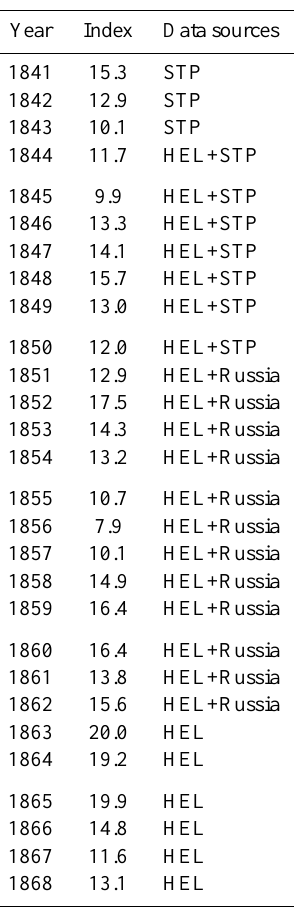
Table 3. Extended aa-index series from Helsinki four Russian ob- servatory data